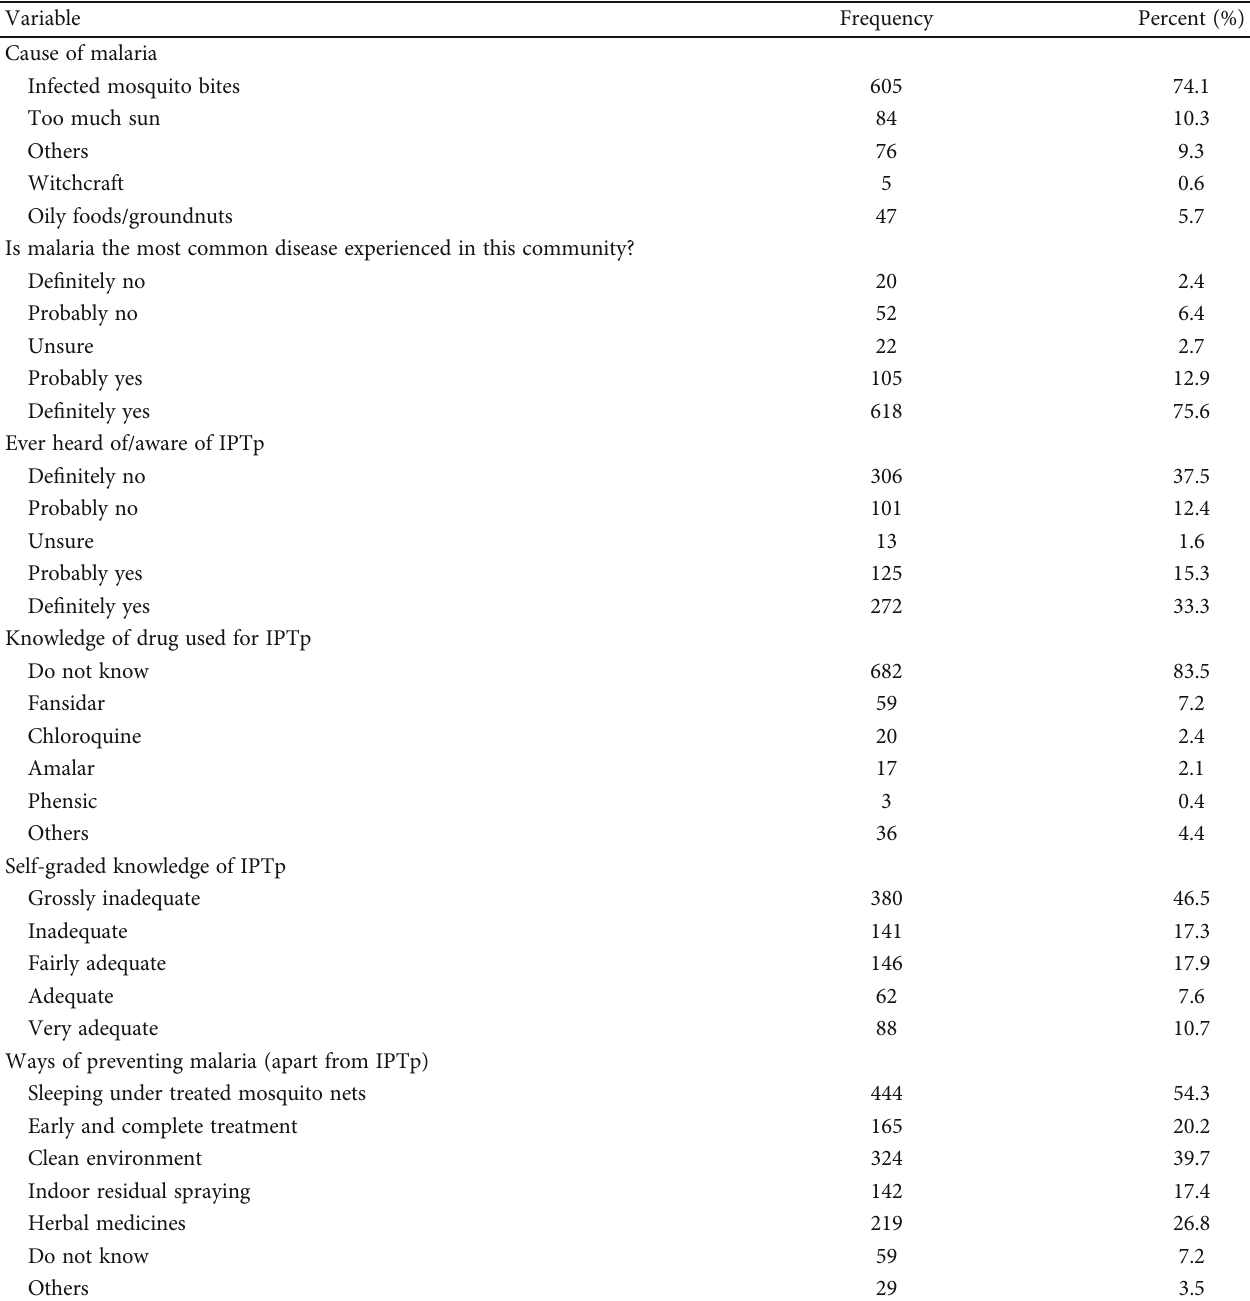
Table 3: General knowledge of malaria and intermittent preventive therapy in pregnancy (IPTp) among community members in Ebonyi, Nigeria ( n = 817